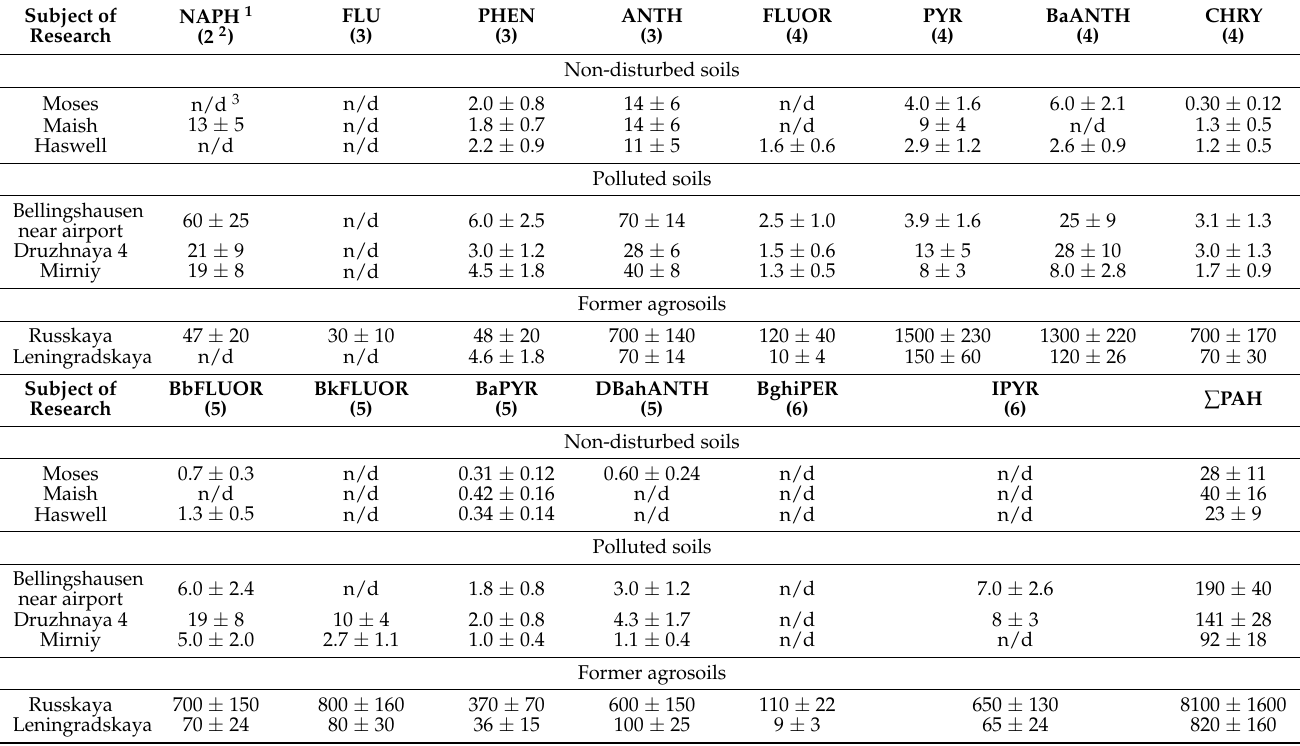
Table 1. Mass fraction of PAHs (ng/g) in Antarctica soils.